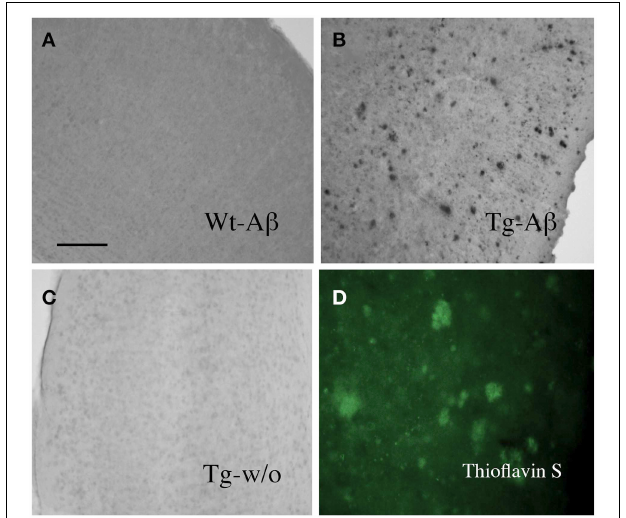
FIGURE 1 | Beta-amyloid plaques in the amyloid-precursor protein_SDI mouse model vibrosections. Organotypic vibrosections (120 µ m thick) of 9 month old wildtype (Wt, A ) or transgenic (Tg, B–D ) mice were prepared and cultured for 2 weeks, then fixed and immunohistochemically stained for beta-amyloid (A–C) or Thioflavin S (D) . As a control Tg sections were stained without primary antibody (C) . Note a dense number of plaques in 2 week old cultured vibrosections of 9 month old APP_SDI mice (B) . Scale bar in A = 200 µ m (A–C) and 120 µ m (D) .